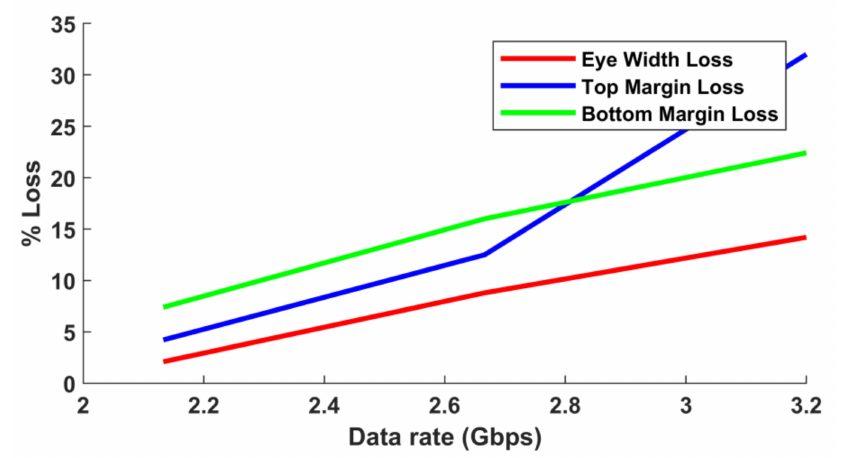
Figure 9. Eye width loss and voltage margin loss with increasing data